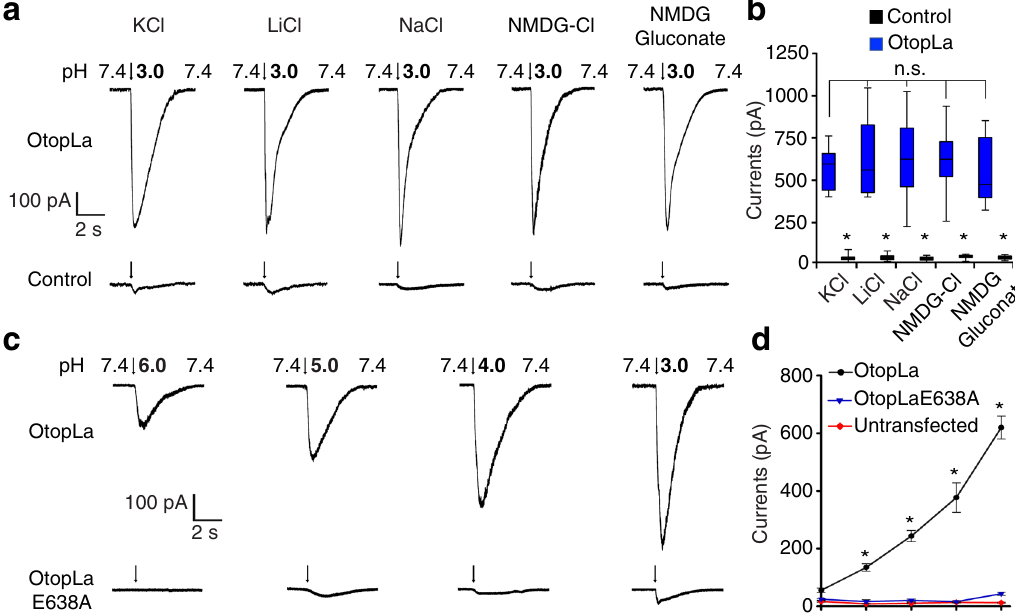
Fig. 6 Currents evoked by acidic pH in HEK293 cells expressing OtopLa or OtopLaE638A. a Representative currents produced by the stimuli of acidic isosmotic solutions (pH 3.0) of KCl, LiCl, NaCl, NMDG-Cl, or NMDG-gluconate in HEK293 cells with or without OtopLa expression. Arrows indicate the onset of stimuli. b Statistical analysis of current amplitudes in HEK293 cells with or without OtopLa expression in various bath solutions containing KCl, LiCl, NaCl, NMDG-Cl, or NMDG-gluconate. n = 11 cells, * p < 0.0001 for all bath solutions, unpaired two-tailed t -tests. One-way ANOVA tests comparing current amplitudes of OtopLa-expressing cells in KCl, LiCl, NaCl, NMDG-Cl, and NMDG-gluconate bath solutions gave p = 0.95, indicating no signi fi cant differences among these fi ve bath solutions. In the box and whisker plot, top and bottom whiskers represent the maximum and the minimum, respectively; top and bottom box boundaries represent third and fi rst quartiles of the data, respectively; and the center line represents the median. c , d Currents elicited by acidic isosmotic solutions (pH 3.0 – 6.0) in HEK293 cells expressing OtopLa or OtopLaE638A, and controls. NMDG-gluconate as bath solution. Arrows in c indicate the onset of stimuli. Data are presented as mean ± SEM. n = 12 cells, * p < 0.0001 (pH 3.0 – 6.0), one-way ANOVA